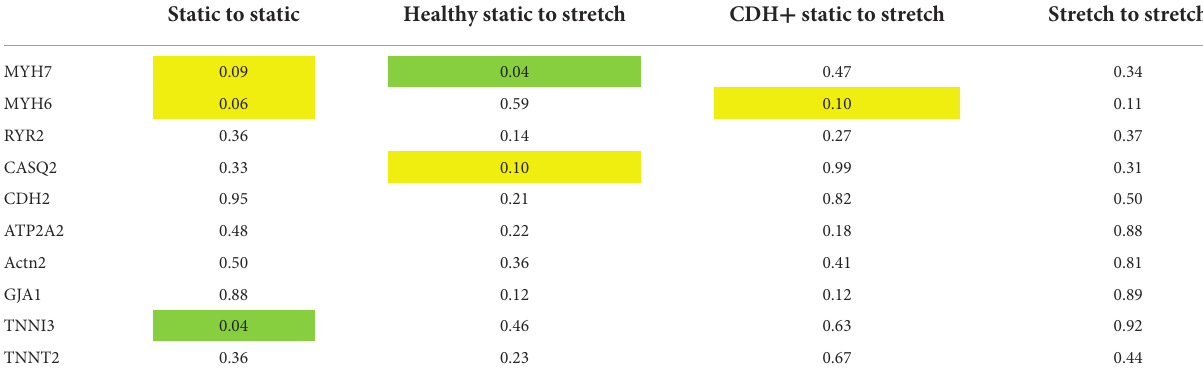
TABLE 2 Gene expression with